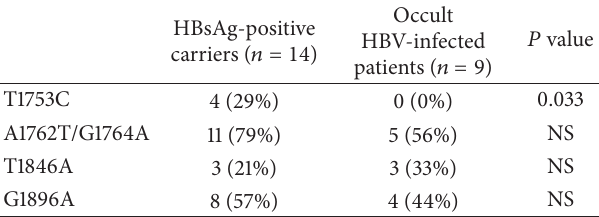
Table 5: Mutations in the core promoter and precore regions in patients divided by serological